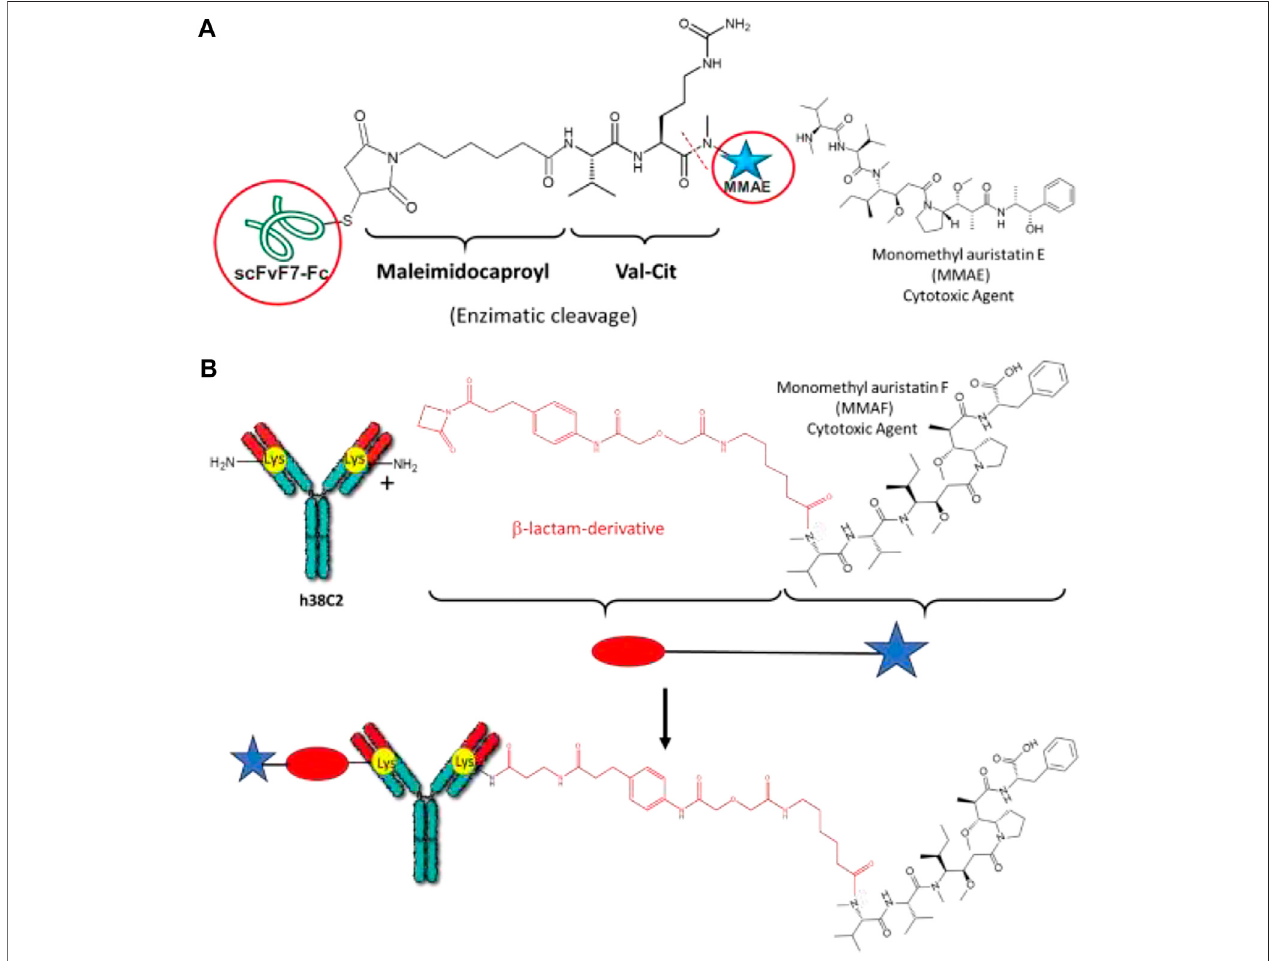
FIGURE7|(A) Structuresofthedrug(MMAE)andmAb-drugconjugate. (B) Conjugationofthehumanizedanti-haptenmonoclonalantibody(mAb)h38C2through nucleophilic lysine with β -lactam derivatives (i.e., β -lactam functionalized monomethyl auristatin F (MMAF).